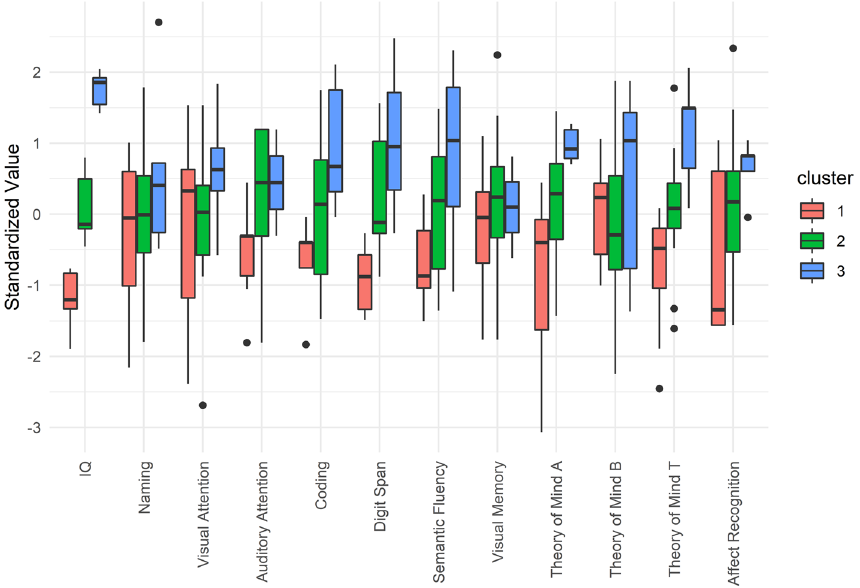
Figure 2. The pattern of neuropsychological functioning obtained through the cluster analysis. The three clusters are represented in three colors (red, green, and blue). The standardized value of each variable is depicted as a boxplot for each cluster. The solid black line represents the mean, the box edges are the first and third quartiles, and the circles are outliers, defined as outside 1.5 times the interquartile range (whiskers) above the upper quartile and below the lower quartile.